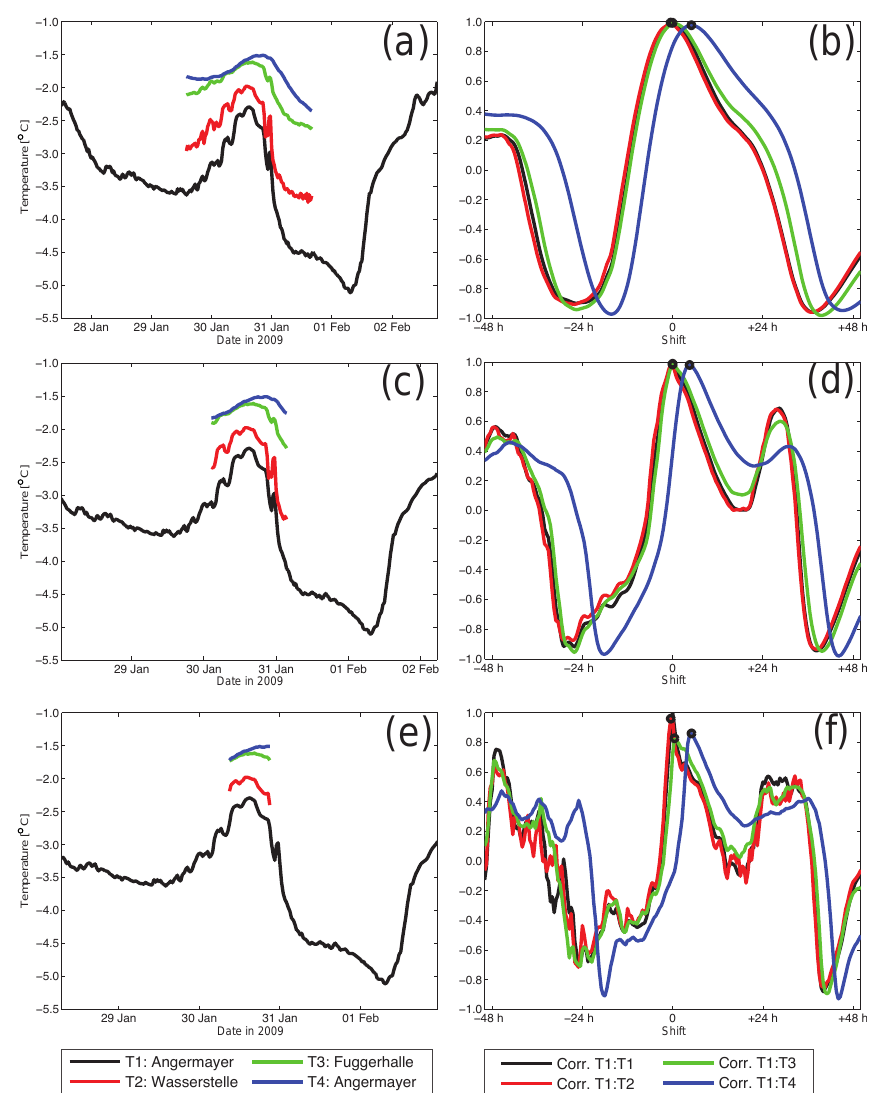
Figure 4. Observed temperatures (left panels) and correlation functions (right panels) during a period of large temperature variations, well suited for correlation analysis. Data of loggers T2, T3, or T4 are cross-correlated with the data of logger T1 using a correlation length of 101 (a, b) , 51 (c, d) , and 25 (e, f)